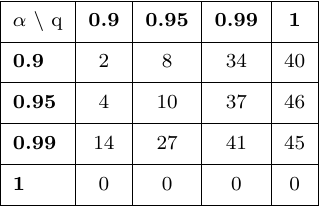
Table 1. Number of zeros of the function Φ ( q,s,α ) in the region R . α \